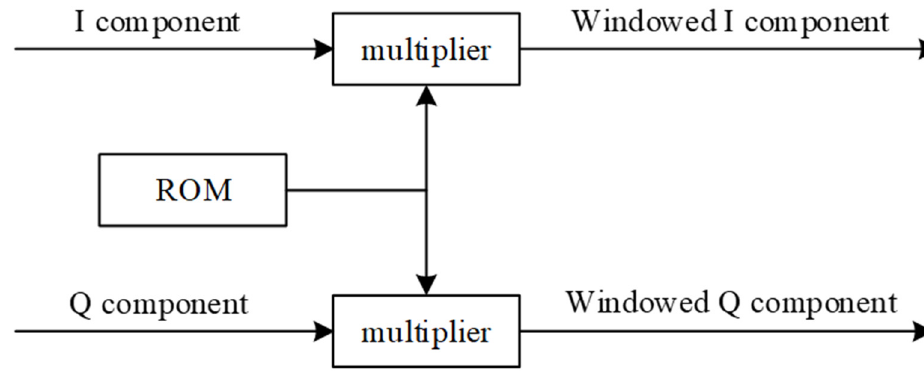
Figure 7. Windowing